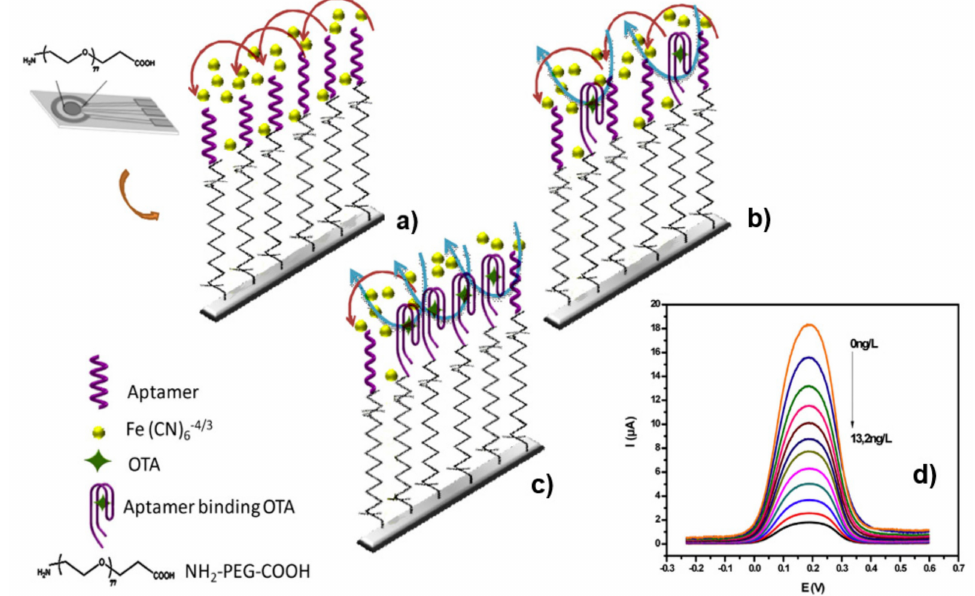
Figure 4. Schematic representation of a strategy involving unlabeled aptamers for the fabrication of an electrochemical aptasensor for ochratoxin A: ( a ) efficient electron transfer between the redox probe and electrode in the absence of the analyte; ( b ) inhibition of the electron transfer induced by the aptamer conformational change upon analyte binding; ( c ) further blocking of the electron transfer upon the additional increase in analyte concentration; ( d ) square wave voltammograms (SWV) depicting the decrease of the redox current with the analyte concentration. Reprinted with permission from [115]. Copyright 2015